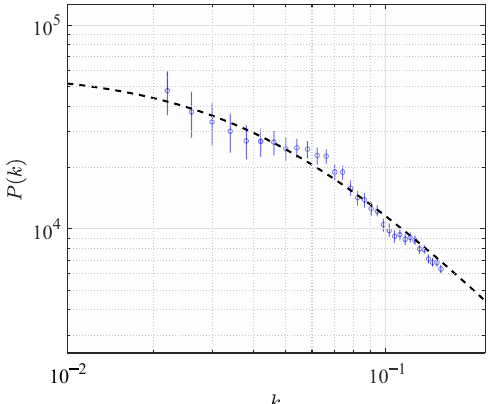
Figure 3. 2dFGRS galaxy power spectrum [30] (dots) and its UZ approximation (dashed line) with A = 586.21, b = 1.22808, c = 0.99, α = 1.53515. Adapted with permissions from IOP Publishing